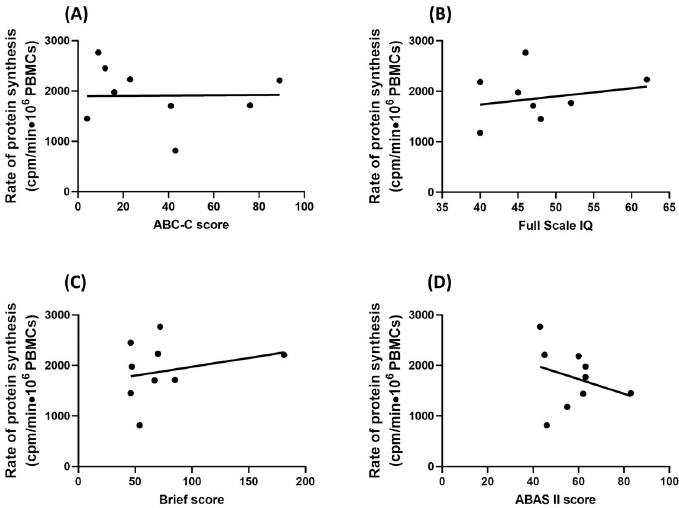
Fig 4. No association between rate of protein synthesis in fragile X individuals PBMCs and cognitive evaluation. (A) ABC-C score (B) Full Scale IQ (C) Brief score and (D) ABAS-II score. No clear correlation is observed.